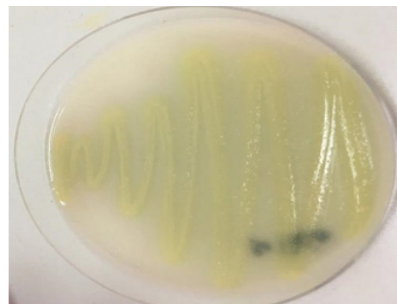
Fig. 4. Antibiotic Resistance Test for Staphylococcus sp. and Pseudomonas sp